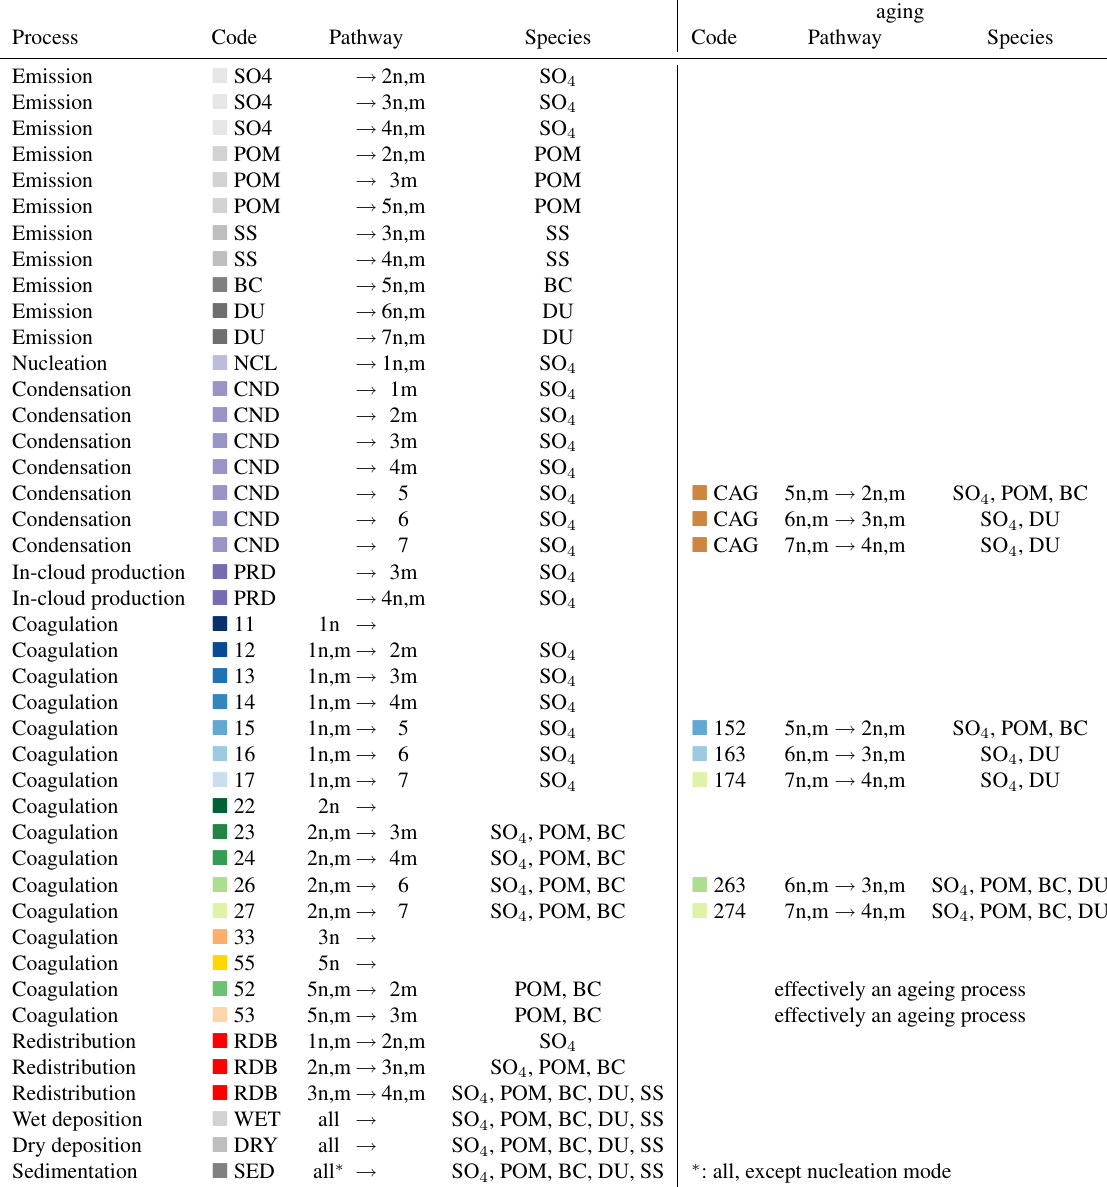
Table 2. Aerosol processes in ECHAM-HAM. The columns present from left to right: the process; the identification code used in various figures; the exact pathway, using numbers to identify mode and letters to identify number (n) or mass (m) tendencies; the species involved. In the right two columns, specific aging processes are detailed. In ECHAM-HAM they are the instantaneous result of some process mentioned on the